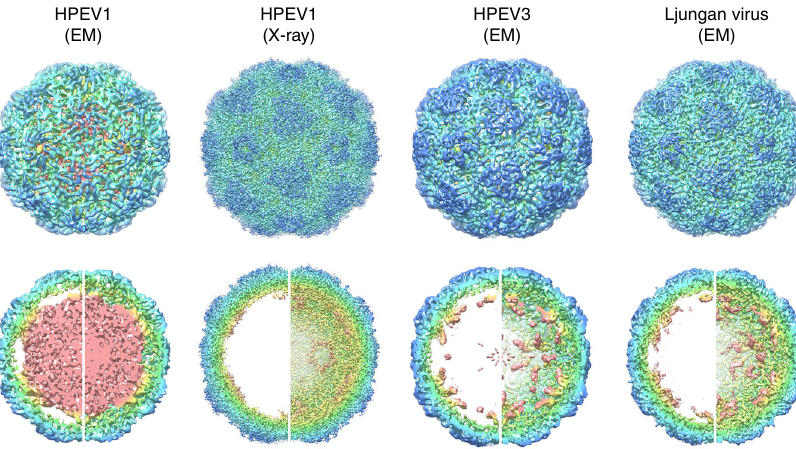
Fig. 1 Ordered RNA segments in the structures of picornaviruses. Four icosahedrally-symmetric structures for parechovirus virions are currently available. These are HPeV1 (Cryo-EM, 8.5 Å resolution, EMD-1690) 7 , HPeV1 (X-ray crystallography, 3.1 Å resolution, PDB 4Z92) 4 , HPeV3 (Cryo-EM, 4.3 Å resolution, EMD-3137) 8 , and Ljungan virus (Cryo-EM, 4.5 Å resolution, EMD-6395) 5 . On the top row , an exterior view of each capsid is shown, viewed perpendicular to an icosahedral two-fold axis. On the bottom row , each virus is shown in the same orientation, as a 60 Å thick central section on the left hand side, and the rear half of the capsid on the right hand side. All panels are coloured with an identical radial colour scheme ( red : 98 Å, yellow : 111 Å, green : 124 Å, cyan : 137 Å, blue : 151 Å). The diameters of all capsids are very similar, with density ascribed to RNA shown in yellow / red in each case. More RNAs can be seen in the lower resolution HPeV1 EM reconstruction at 8.5 Å, than in the X-ray density at 3.1 Å resolution, suggesting that only a few nucleotides are identical in all 60 positions, but similar stem-loops occupy all